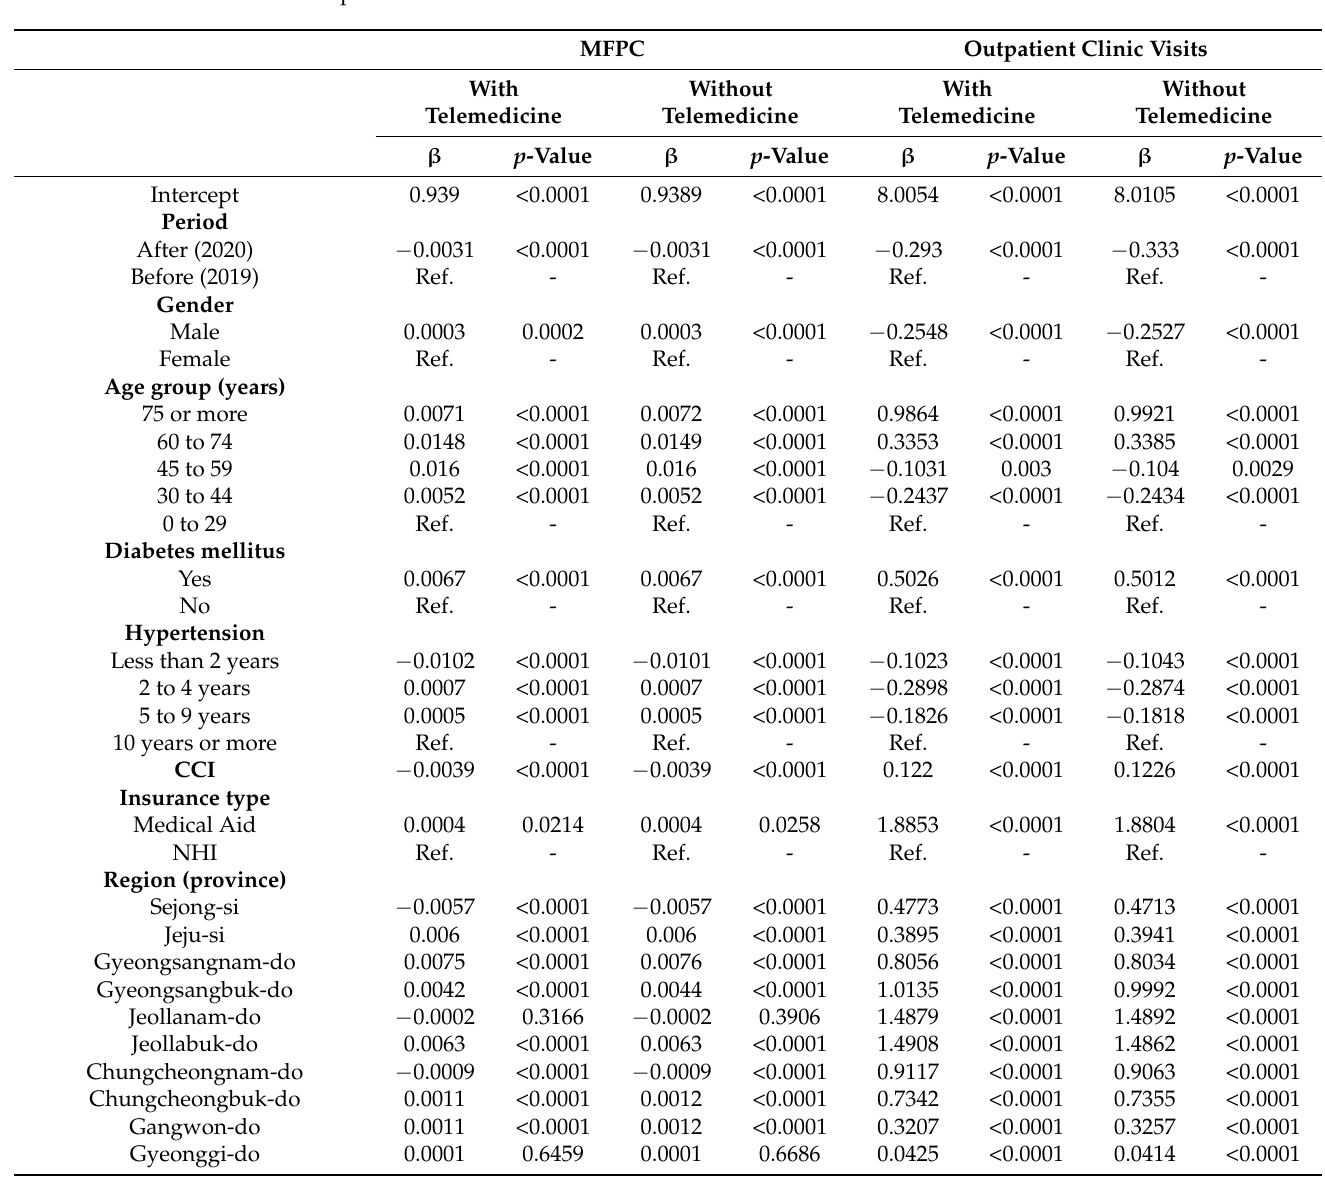
Table 4. Impact of the COVID-19 protocols on MFPC and the number of outpatient clinic visits per patient. MFPC Outpatient Clinic Visits With